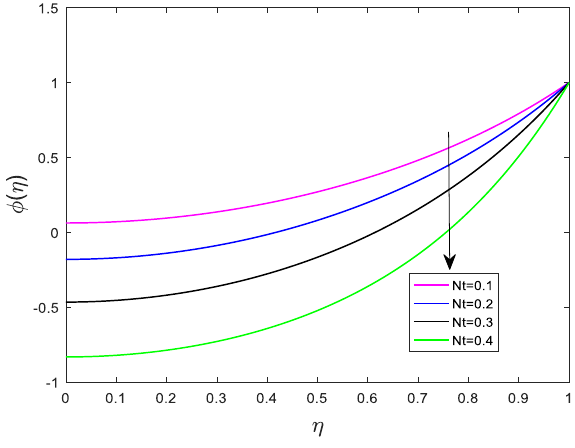
Figure 20: Effect of N b on θ ( η ) for fixed S = 1.5, β = Ω T = Ω C = 0.1, N t = 0.2, Ha = 0.8, Ec = 0.3, Pr = 0.7, Kr = 2.0 and Sc = 2.0